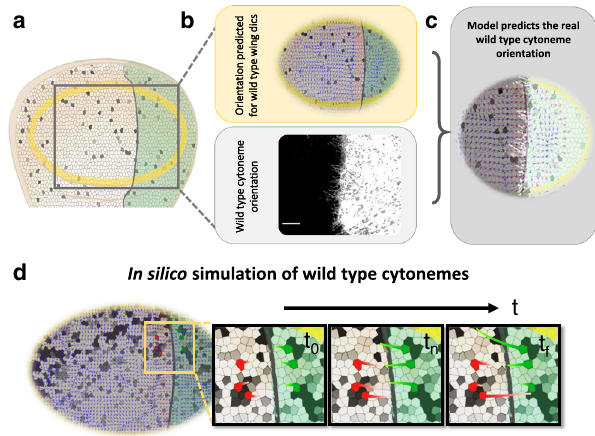
Fig. 7 | In silico simulation of cytoneme orientation in wild-type wing discs. a Schemedepictingawingimaginaldisc. b Guidance fi eldprediction(smallarrows) in a wing disc using experimental wild-type distributions of Ihog, Dally and Dlp (top). Wild type orientation of P compartment cytonemes, marked with CD4- tomato (bottom). c The model predicts cytoneme orientation in wild-type condi- tions. d In silico predictions for cytoneme temporal growth on wild-type